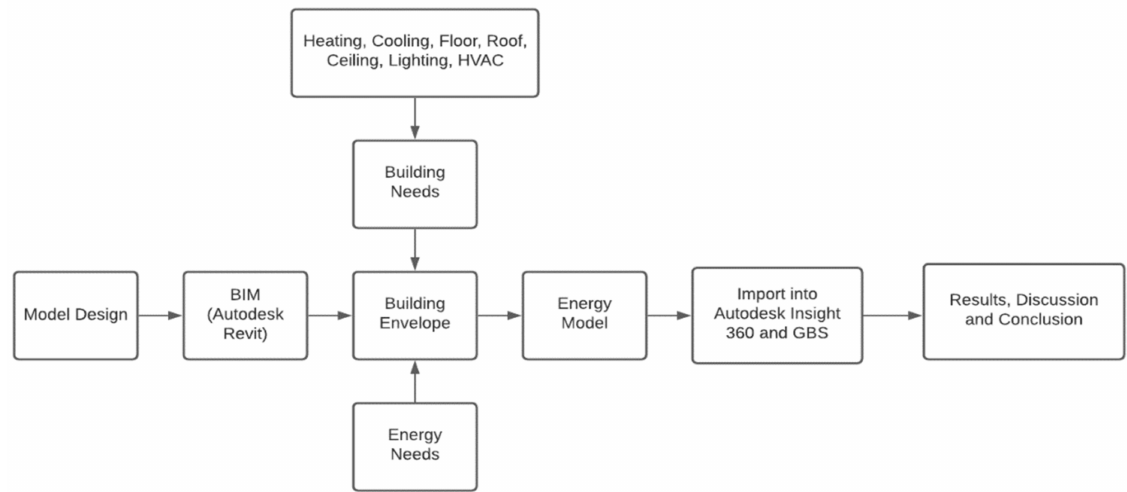
Figure 3. Revit modeling workflow.